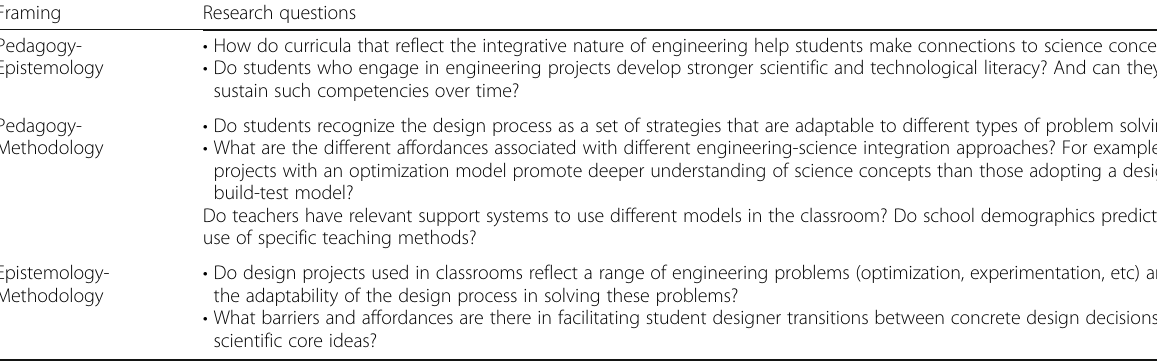
Table 4 Research questions to guide teaching and learning Framing Research